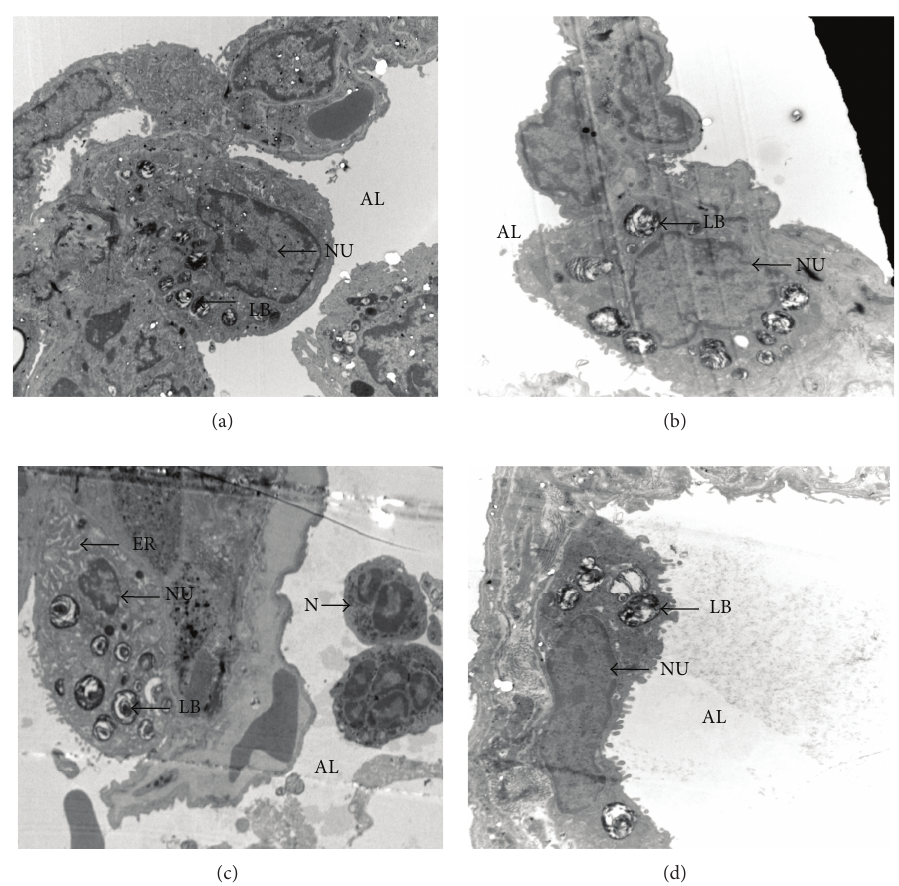
Figure 7: Effect of EGCG pretreatment on pulmonary ultrastructure. (a) Control group: the normal alveolar epithelial cell type II and thin alveolar (AL) wall. (b) EGCG group: there was no obvious change in pulmonary ultrastructure compared with control group. (c) Seawater group: neutrophil (N) infiltration in the alveolar lumen and thickened alveolar wall were observed. Meanwhile, endoplasmic reticulum expanded and lamellar bodies(LB)emptying increased. (d)Seawater + EGCGgroup: thechange of alveolar wall and thealveolar epithelial cell type II were alleviated compared with seawater group ((a) 5000 × ; (b) 4000 × ; (c) 5000 × ; (d) 8000 × ). NU: nucleus; ER: endoplasmic